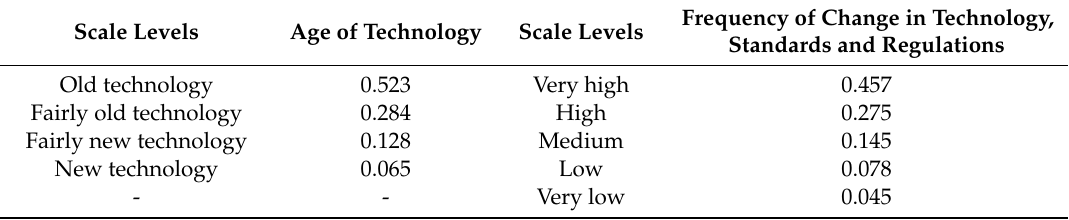
Table 11. Weightings of the scale levels of the other descriptors of the criterion Age of device. Scale Levels Age of Technology